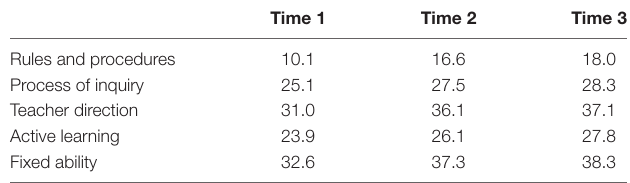
TABLE 3 | Mean composite scores for survey categories.